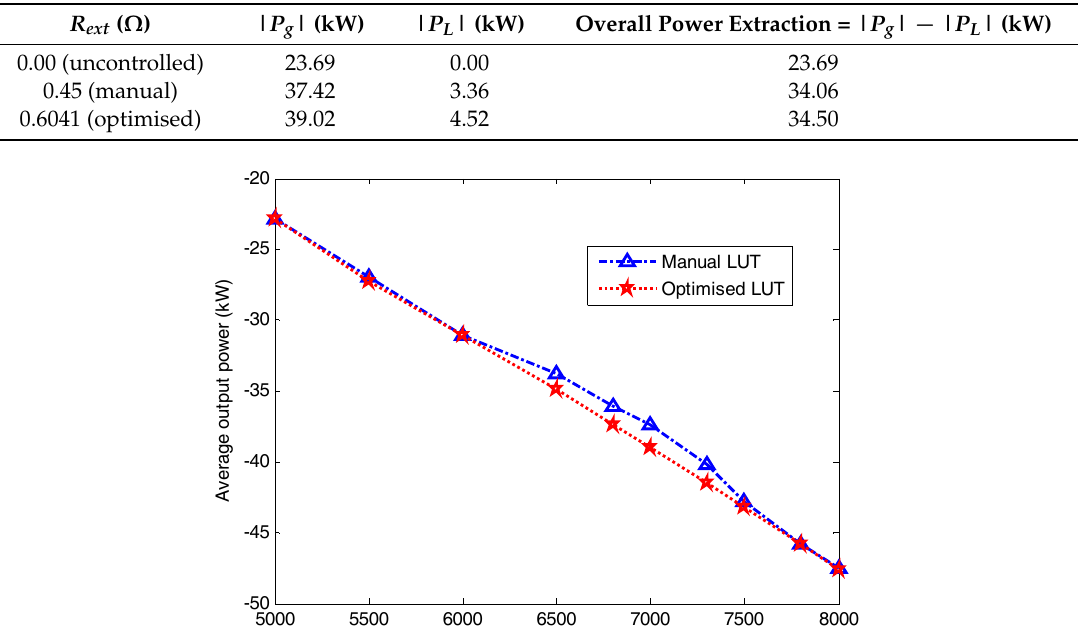
Figure 8. Input pressure for dP = | 7000 sin (0.314 t )| Pa .